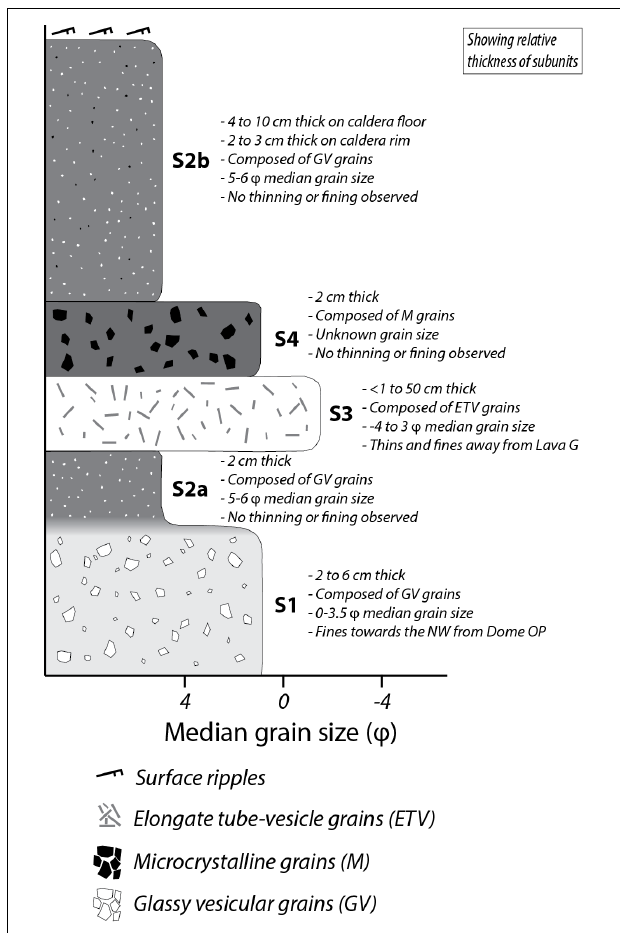
FIGURE 6 | Idealized schematic stratigraphic column of the AL unit showing S1, S2 (a and b), S3, and S4, noting deposit characteristics.